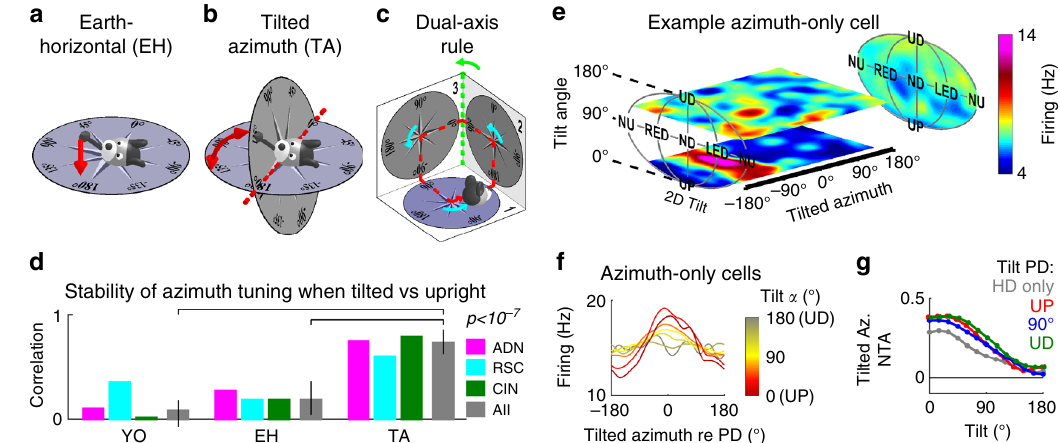
Fig. 3 Encoding of azimuth is also in fl uenced by gravity. a Illustration of the earth-horizontal (EH) frame, where azimuth direction is projected onto the earth-horizontal plane (dashed red line). b Tilted azimuth (TA) frame 14 , where azimuth is de fi ned by rotating head direction (gray vector) towards the horizontal plane instead of projecting it. The head has the same 3D orientation in a and b but its azimuth is different in the two frames (EH: 165°; TA: 135°). c Dual-axis rule for updating TA, illustrated by an example trajectory (red) where the animal travels in 3D across three orthogonal surfaces (numbered 1 to 3). Head azimuth is updated when the head rotates in yaw within one surface ( fi rst rule, cyan arrows) or in the earth-horizontal plane (second rule, green arrow when transitioning from surface 2 to 3). The fi rst rule tracks azimuth and the second rule ensures that the brain compass always matches the EH compass along the line intersecting the two planes (the 0 – 180° line in b ). d Correlation between azimuth tuning curves when upright (<45° tilt) vs. tilted (>60°) in YO, EH and TA frames. Colored bars: Median correlation in each brain region. Lines: 95% con fi dence intervals. Gray bars: data pooled across all cells. p -value based on a Wilcoxon-signed rank test across all cells. e 3D tuning curve of an example azimuth-only cell, showing horizontal slices at tilt angles of 30° and 110° (see animations in Supplementary Movie 7). The average tilt tuning (across all azimuths) is shown on the right panel. f Average azimuth tuning curve of all azimuth-only cells that maintained their azimuth tuning in the rotator ( n = 10), averaged across all tilt orientations ( γ ), computed at tilt angles ( α ) ranging from 0 to 180° and centered on PD = 0°. g Average normalized tuning amplitude of the azimuth tuning curve as a function of tilt angle, computed for azimuth-only cells ( n = 10, gray) and conjunctive cells with preferred tilt directions near upright (<75° tilt, red, n = 16), near 90° tilt (±15°, blue, n = 22) and near upside-down (>105°, green, n = 15). Source data are provided as a Source Data fi